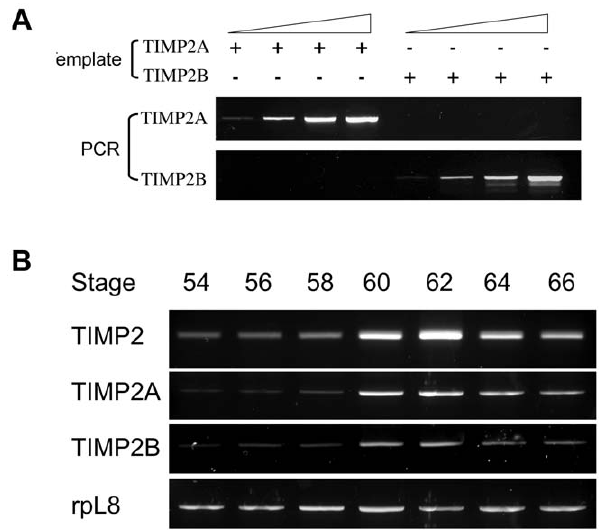
Figure 4. Co-regulation of TIMP2A and TIMP2B expression during intestinal metamorphosis. A) Validation of primer specificity for X. laevis TIMP2A or TIMP2B. The TIMP2A and TIMP2B cDNA were cloned into pCR2.1 vector, sequenced and serially diluted to serve as template DNA for PCR. Note that each primer pair specifically amplified only the intended TIMP2 gene. B) Total RNA was isolated from intestines of tadpoles during X. laevis metamorphosis and subjected to One-Step RT-PCR with a pair of primers recognizing both TIMP2 genes (TIMP2), specific for either TIMP2A or TIMP2B, respectively. The expression of the house-keeping gene rpL8 was similarly determined as a control.